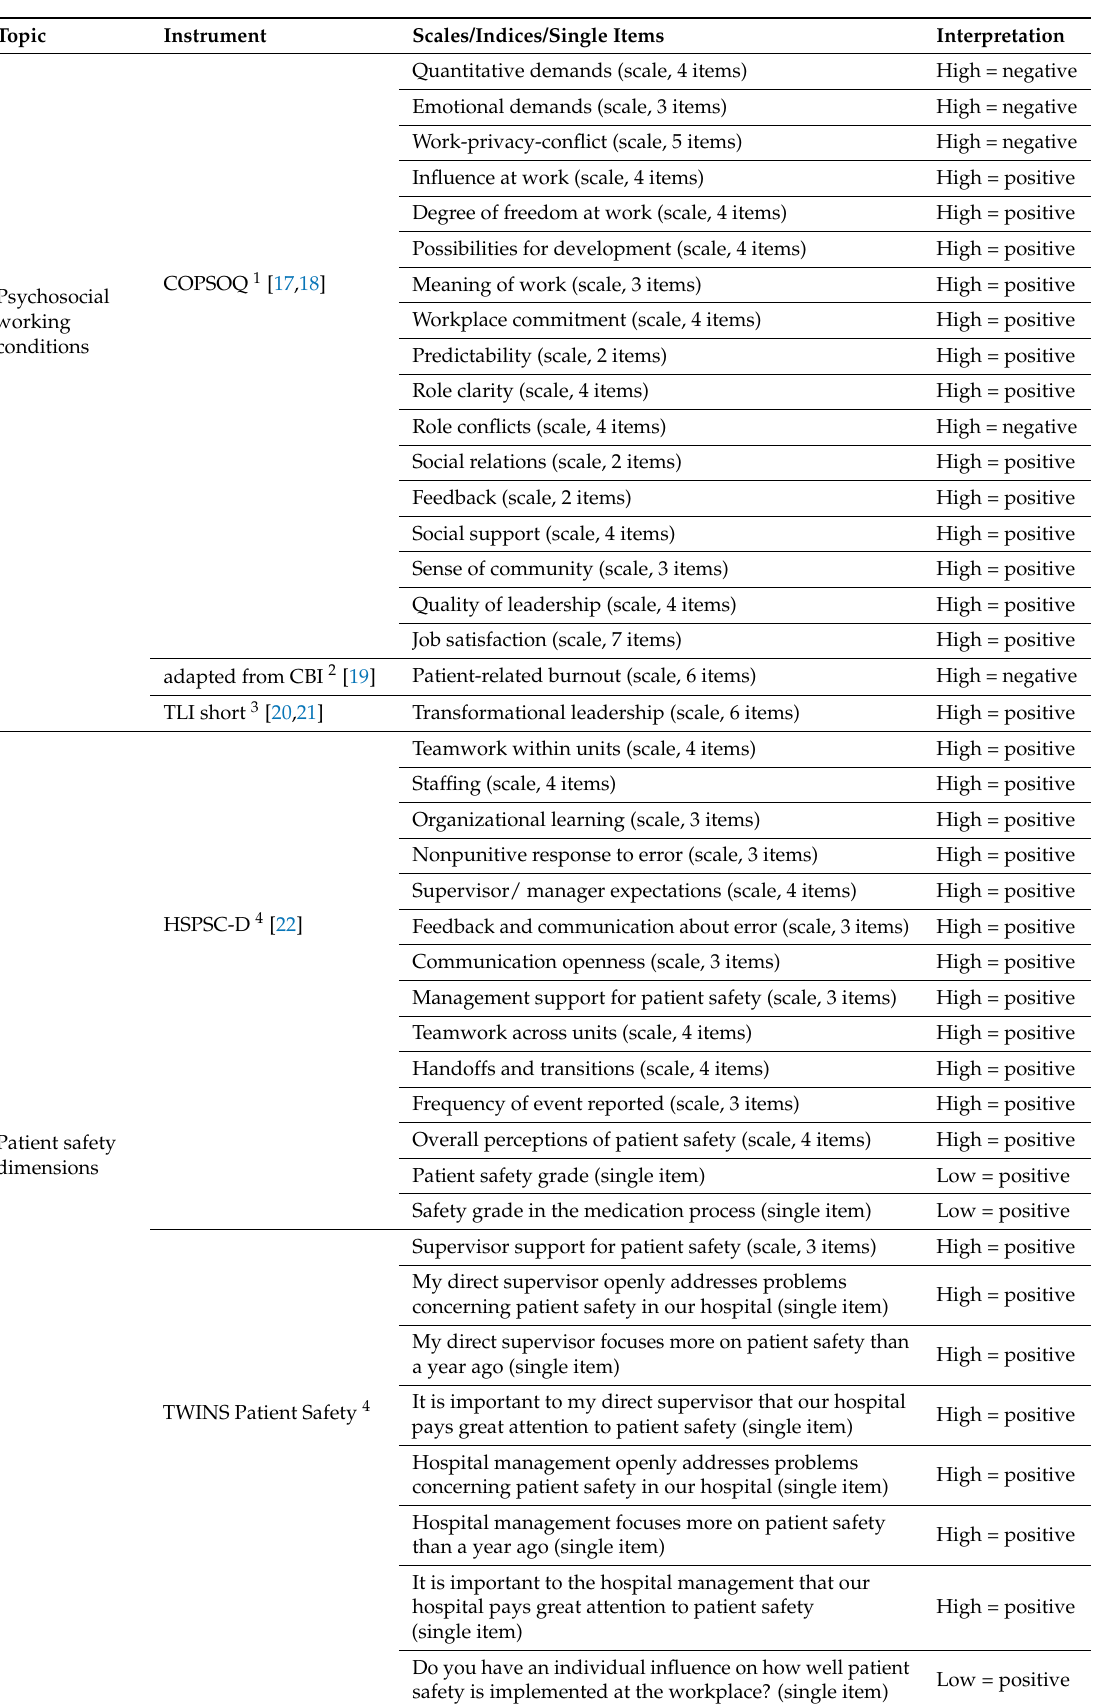
Table 1. Overview of scales and items of the